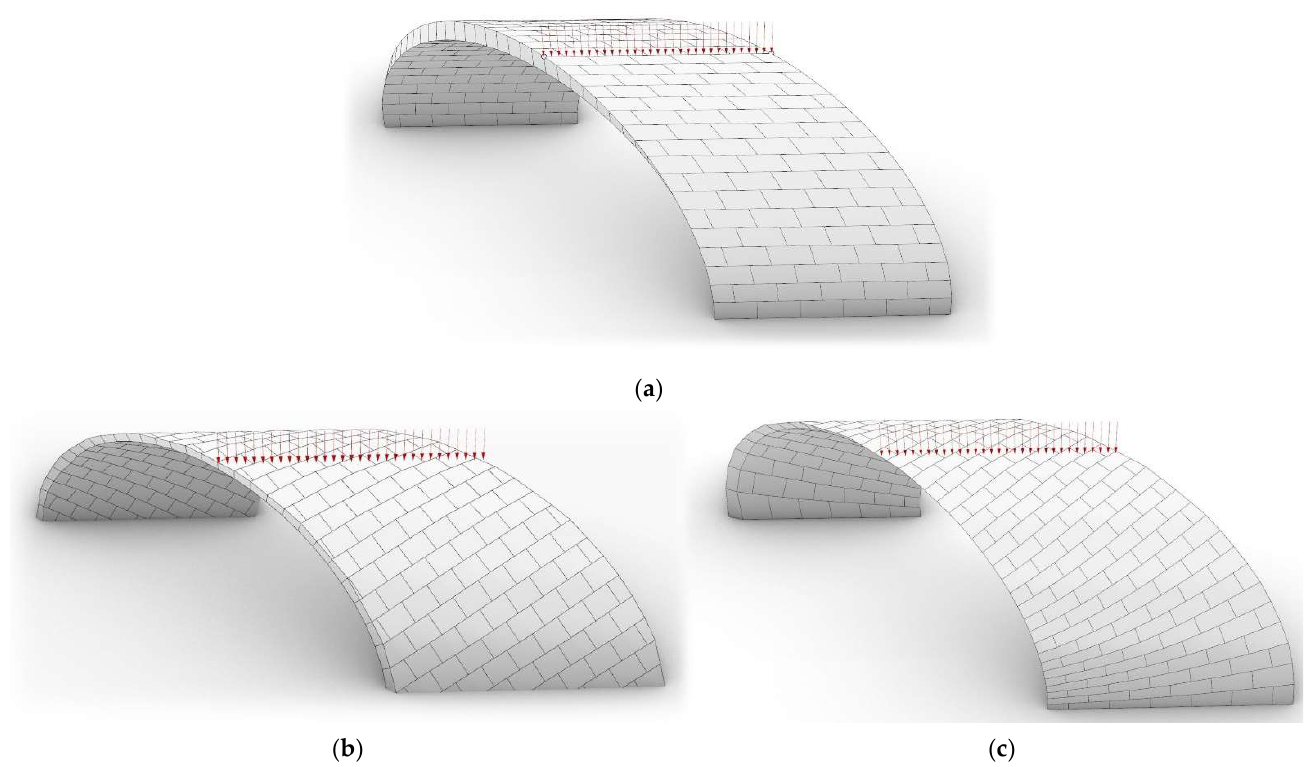
Figure 1. Three stereotomy techniques generating three different joint layouts with different load- bearing capacities: ( a ) false skew arch; ( b ) helicoidal method; ( c ) logarithmic method. Red arrows represent external loads applied to the arches beside their own weight.